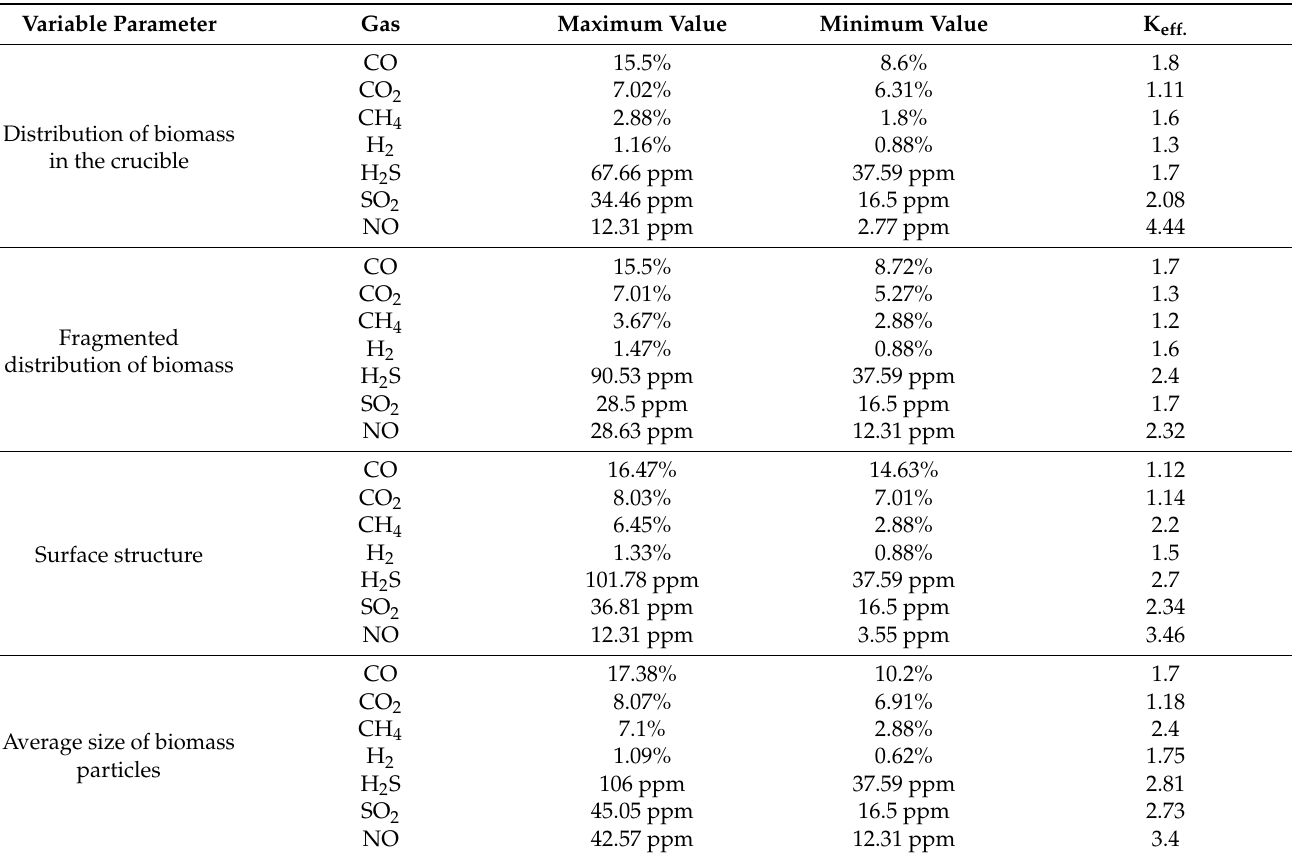
Table 8. Coefficients of microwave pyrolysis